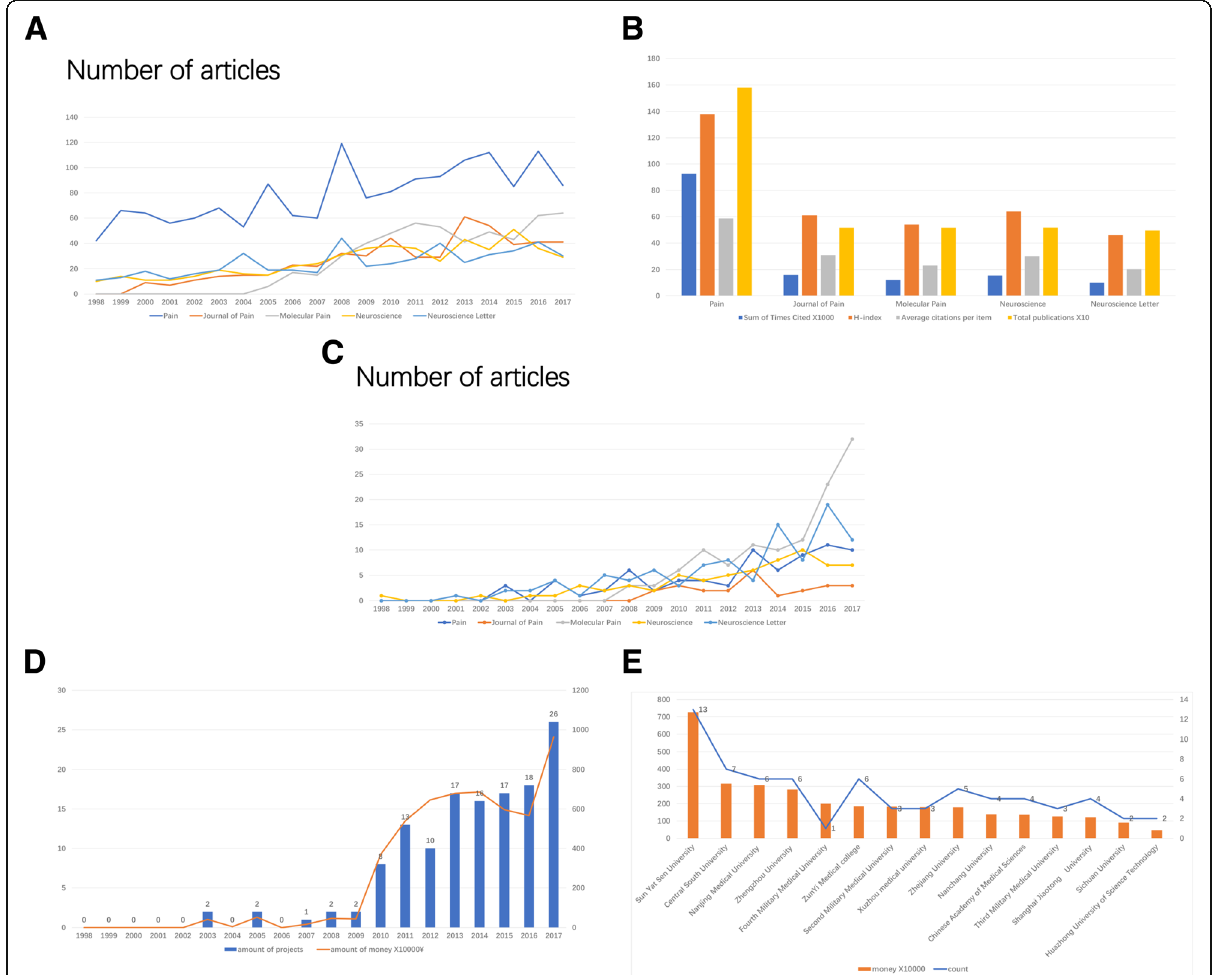
Fig. 4 High contribution journals in neuropathic pain field and funds in China ( a ) The top5 high contribution journals in neuropathic pain field. ( b ) The number of articles for 5 main neuropathic pain journals in world. ( c ) The number of articles for 5 main neuropathic pain journals in China. ( d ) The time curves for NSFC funding in past 20 years. ( e ) NSFC funding of neuropathic pain research at different Chinese